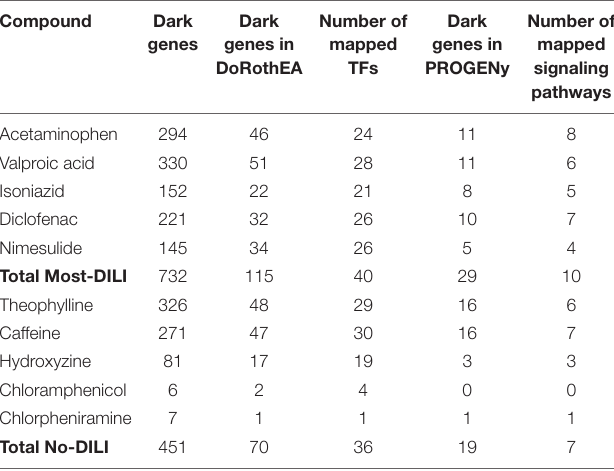
TABLE 6 | Overview of mapped dark genes based on transcriptional regulation (DoRothEA) and on signaling pathway signatures (PROGENy). Compound Dark genes